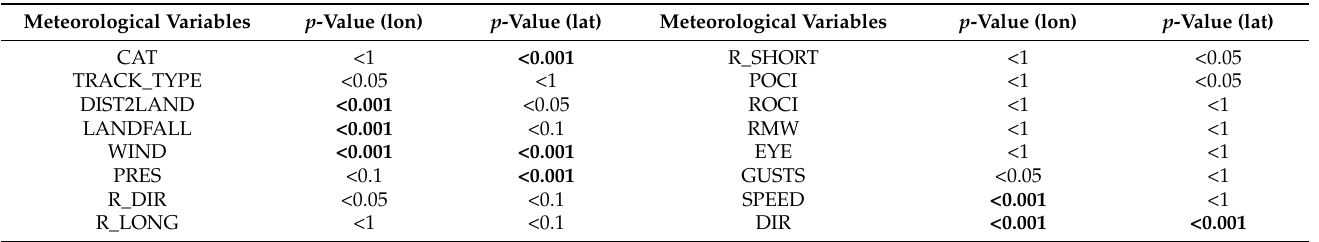
Table 4. Pairwise results of Granger causality tests between meteorological variables and typhoon paths (longitude,